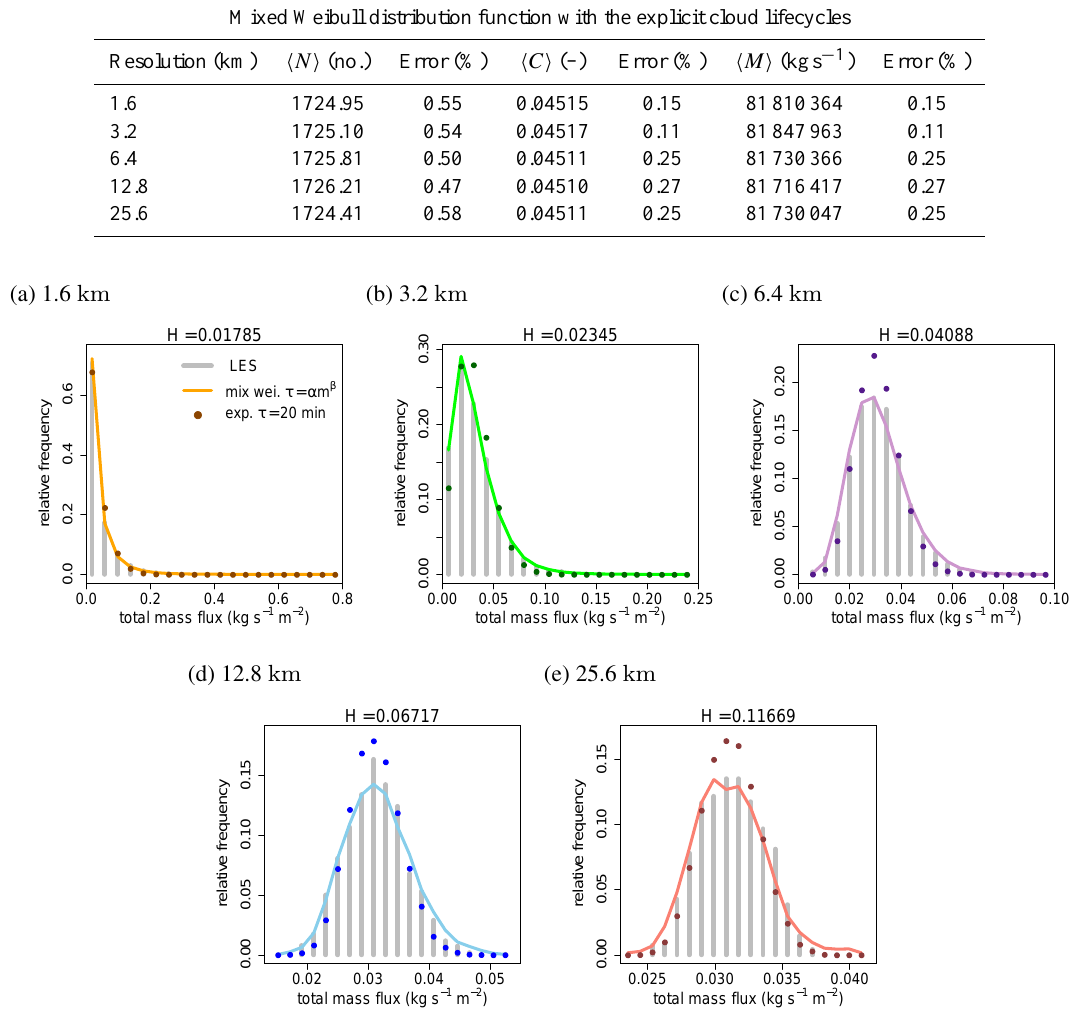
Figure 9. Histograms of the compound cloud mass flux at the 700m height level normalised by the grid box area of the different horizontal resolution: coarse-grained LES tracking results vs. stochastic model results. Plots show the two stochastic model cases: a two-component mixed Weibull case with explicit cloud lifecycles ( k = 0 . 7; coloured lines) and a single-mode exponential case without cloud lifecycles ( k = 1; coloured dots). Colours also correspond to Fig. 5. Hellinger distance H stands for the mixed Weibull case.